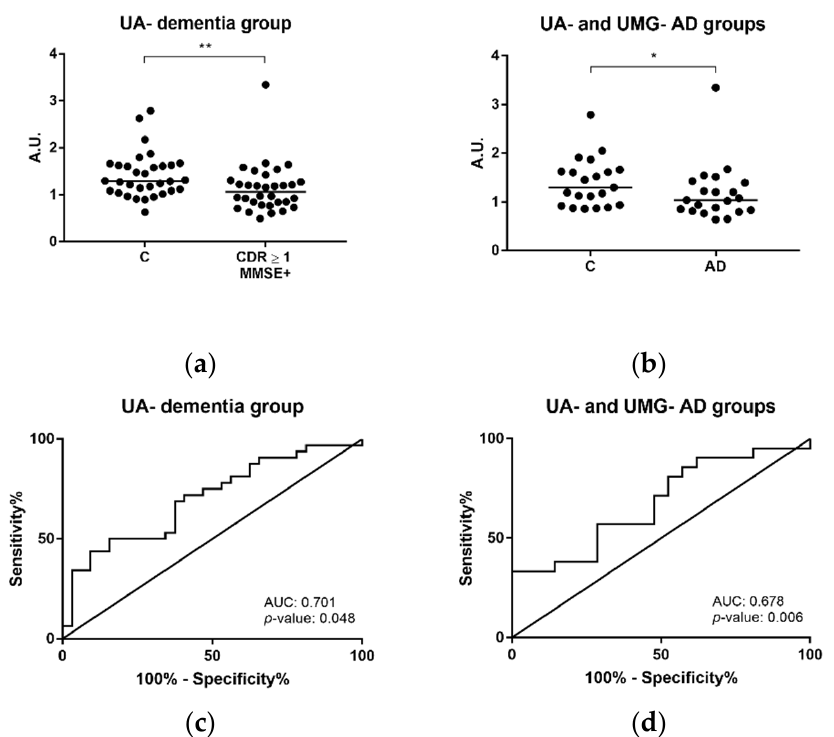
Figure 5. Gelsolin levels in dementia and AD determined by Western blot analysis. Immunoblot analysis of gelsolin in serum-derived exosomes from controls (CDR = 0 and MMSE–) and individuals with dementia (CDR ≥ 1 and MMSE+) from University of Aveiro (UA)-dementia group ( a ), including AD clinically diagnosed cases and controls (UA- and University Medical Center Goettingen (UMG)- groups) ( b ). ROC curves were obtained for the control and dementia group (UA-dementia group) ( c ) and controls and AD cases from UA and UMG ( d ). Each point represents the densitometry ratio obtained for each individual and the solid horizontal line shows median. Abbreviations: AD, Alzheimer’s disease; A.U., arbitrary units; AUC, area under the curve; C, controls; CDR, clinical dementia rating; MMSE, Mini-Mental State Examination; ROC, receiver operating curve. ** p ≤ 0.01, * p ≤